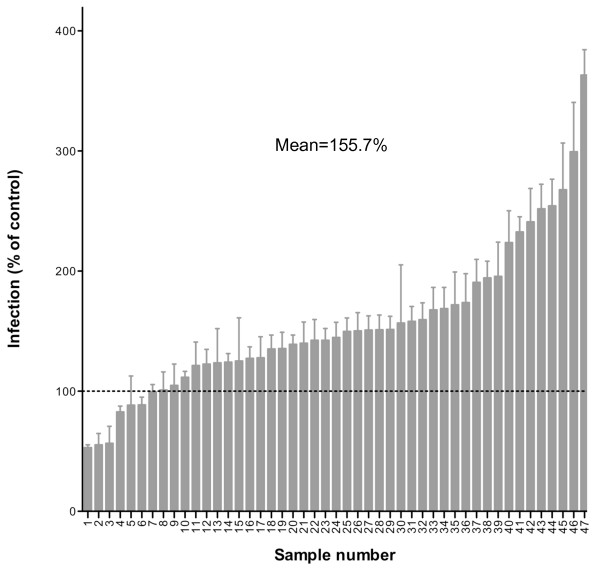
HIV-1 infectivity enhancing properties of human semen samples. 47 semen samples were analyzed for HIV-1-infectivity modulating effects. Results are arranged by infectivity enhancing potency. Semen was used in a 1:16 dilution during preincubation. The Y-axis denotes the infection rate relative to control infections performed without semen (depicted as dotted line) as percentage. Shown are mean values of quintuplicate infections. Error bars represent the standard error of the means.